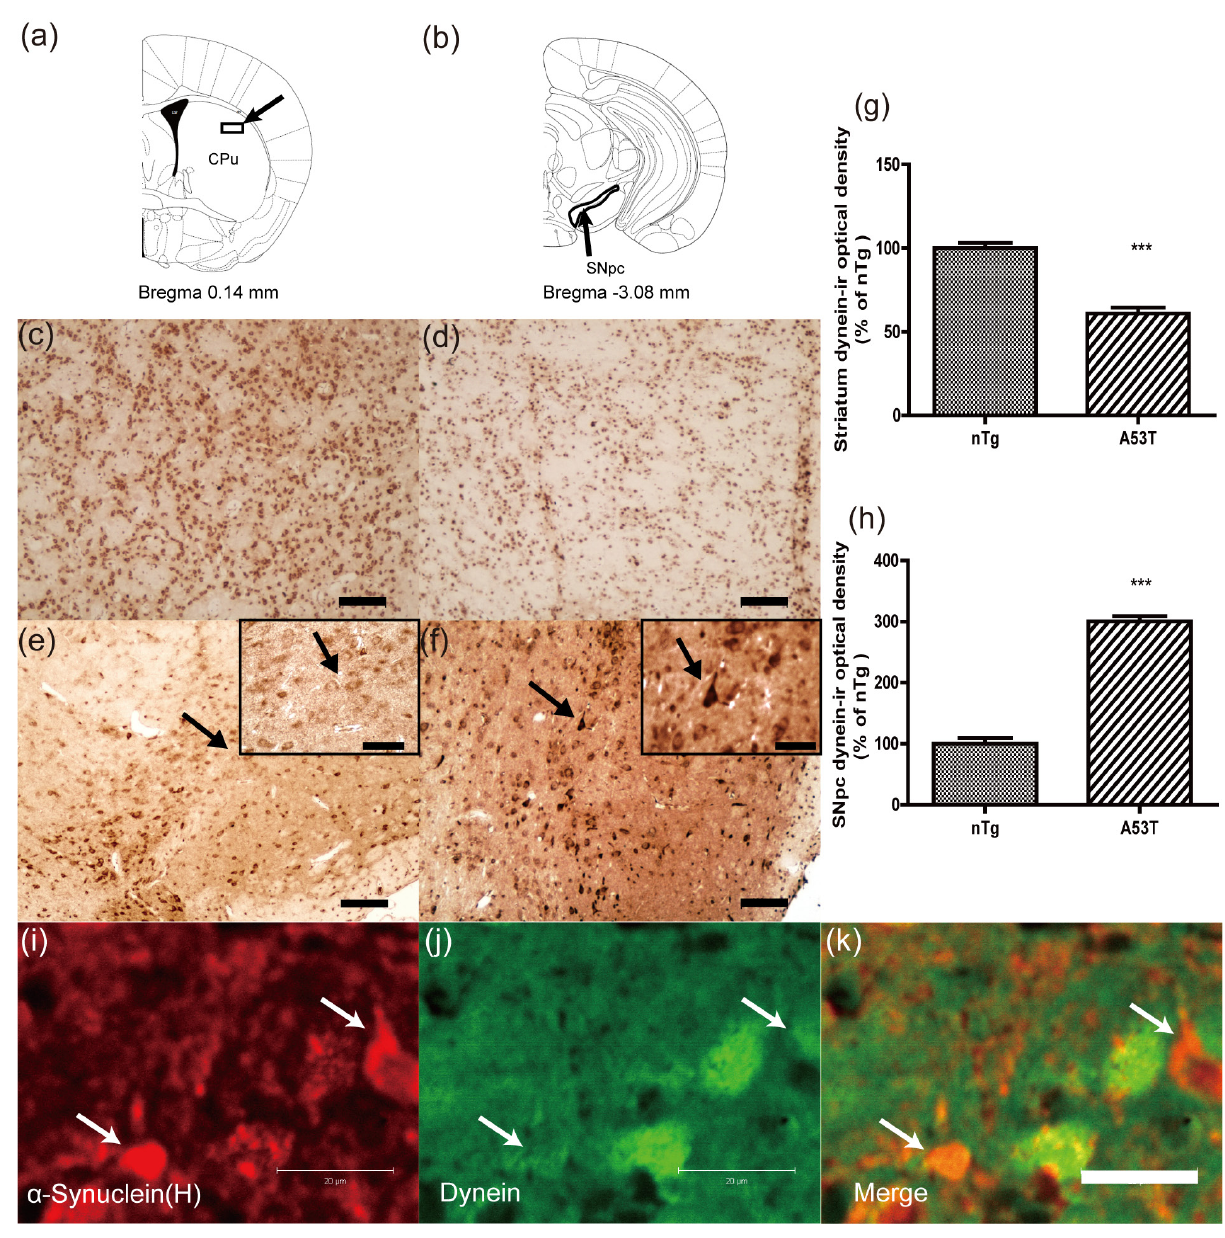
Figure 3. Immunohistochemical analyses of dynein in the striatum and substantia nigra pars compacta (SNpc). Optical density of dynein-immunoreactivity was quantified in the striatum and SNpc as shown in ( a ) and ( b ) 26 . The photomicrographs show the distribution of immunoreactivity for dynein in the striatum ( c – d ) and SNpc ( e – f ). Sections were prepared from nTg mice ( c , e ) and A53T α -synuclein Tg mice ( d , f ). The immunoreactivity for dynein was decreased in the striatum of A53T α -synuclein Tg mice but increased in the SNpc. Insets in ( e ) and ( f ) are high-magnification images of the region indicated by arrows. Abundant dynein accumulation in neuronal perikarya in the SNpc is indicated by arrows in f. The optical density of dynein-ir in the striatum ( g ) and SN ( h ) was quantified (mean ± SEM) and normalized by the averaged value of nTg group (n = 3). *** p <0.001 compared to nTg. A section of the striatum from a 12-month-old homozygous M83 mouse was double labeled with anti- α -synuclein ( i , red) and dynein ( j , green) antibodies. Note that dynein immunofluorescence intensity was extensively reduced in cells with α -synuclein inclusions (arrows, i – k ). Scale bar = 50 μm in ( c – f ); 20 μm in insets and ( i – k